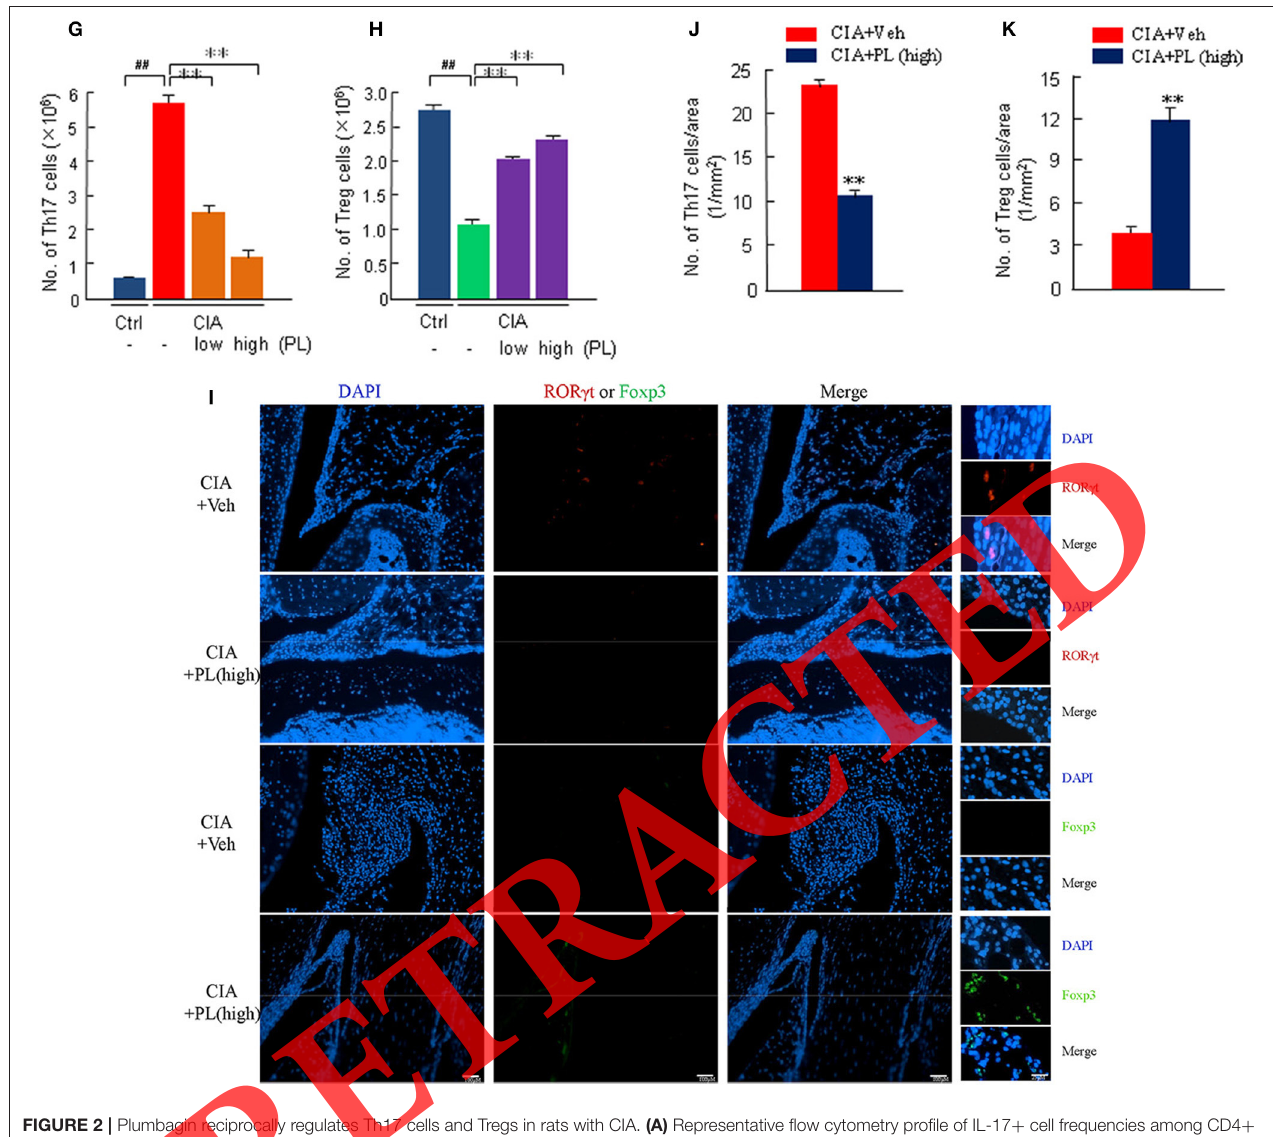
FIGURE 2 | Plumbagin reciprocally regulates Th17 cells and Tregs in rats with CIA. (A) Representative flow cytometry profile of IL-17 + cell frequencies among CD4 + T cells in spleens collected from Ctrl, CIA + Veh, CIA + PL(low), and CIA + PL(high) rats on day 32. (B) Representative flow cytometry profile of Fopx3 + cell frequencies among CD4 + T cells in spleens collected from rats of different groups on day 32. (C,D) Quantitative analysis of IL-17 + and Fopx3 + cell populations in splenic CD4 + T cells from rats of different groups on day 32. (G,H) Th17 cells and Treg cells were counted in the spleens of different groups on day 32. (E,F) Gene expression of ROR γ t and Foxp3 as assessed by qRT-PCR of splenocytes isolated from rats of different groups. (I) Immunofluorescence micrographs of ROR γ t (red) or Foxp3 (green) in the knee joint of the vehicle and plumbagin-treated CIA rats. DAPI (blue) was used to counterstain the nuclei. (J,K) Quantitative analysis of ROR γ t and Foxp3 cell numbers in joint tissues from CIA rats treated with vehicle or plumbagin (high dose). Quantitative results are presented as mean ± SEM, and n = 5/group. ## P < 0.01 vs. normal control rats. * P < 0.05; ** P < 0.01 vs. vehicle-treated CIA